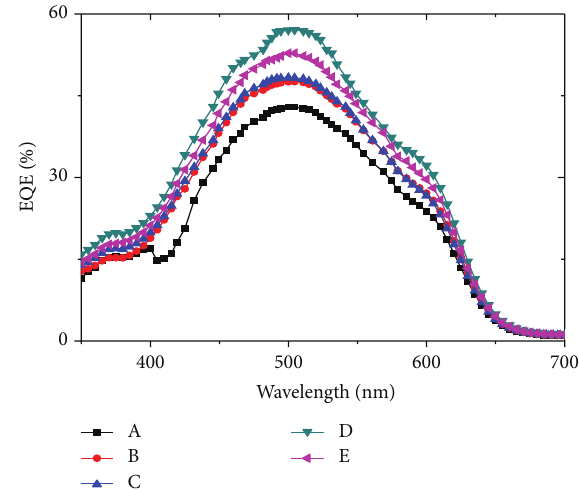
Figure 7: The external quantum efficiency spectra of five devices. A: only PEDOT:PSS solution on ITO at the speed of 3000 rpm. B: the PEDOT:PSS and DMAC mixed in a ratio of 4: 1(v/v) at the speed of 3000 rpm. C, D, and E: the PEDOT:PSS buffer layer modified by DMAC at speed of 1000, 3000, and 5000